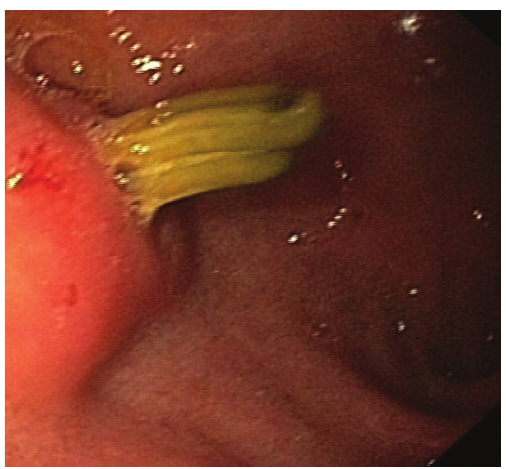
Figure 1: The Hem-o-Lok clip and its applier.